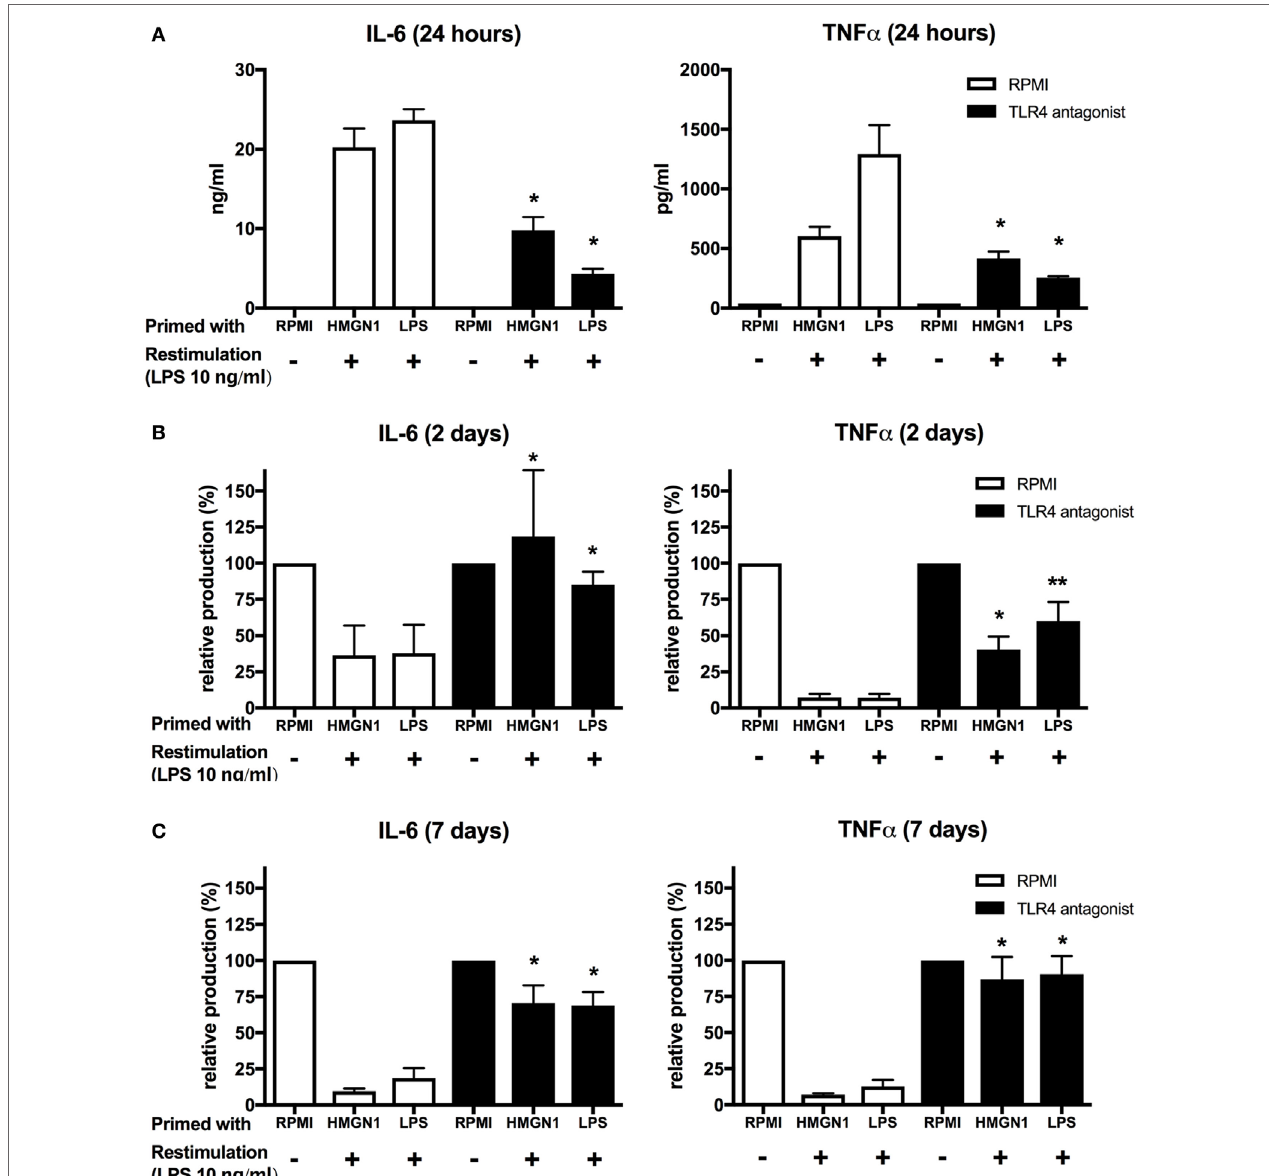
FigUre 4 | High-mobility group nucleosome-binding protein 1 (HMGN1) immunotolerance is dependent on TLR4 ligation. (a) Human peripheral blood mononuclear cells were preincubated with B . quintanea lipopolysaccharide (LPS; TLR4 antagonist) for 1 h and then primed with recombinant HMGN1 or LPS for 24 h. Supernatant was then harvested for IL-6 and TNF- α measurement. The cells were further rested in RPMI containing 10% serum for (B) 24 h or (c) 7 days and then stimulated with LPS or RPMI for additional 24 h. Supernatant was harvested after 24 h stimulation. The IL-6 and TNF- α level were determined by ELISA. The relative production of IL-6 and TNF- α compared to the RPMI control was presented ( n = 4–8 * p < 0.05 vs RPMI